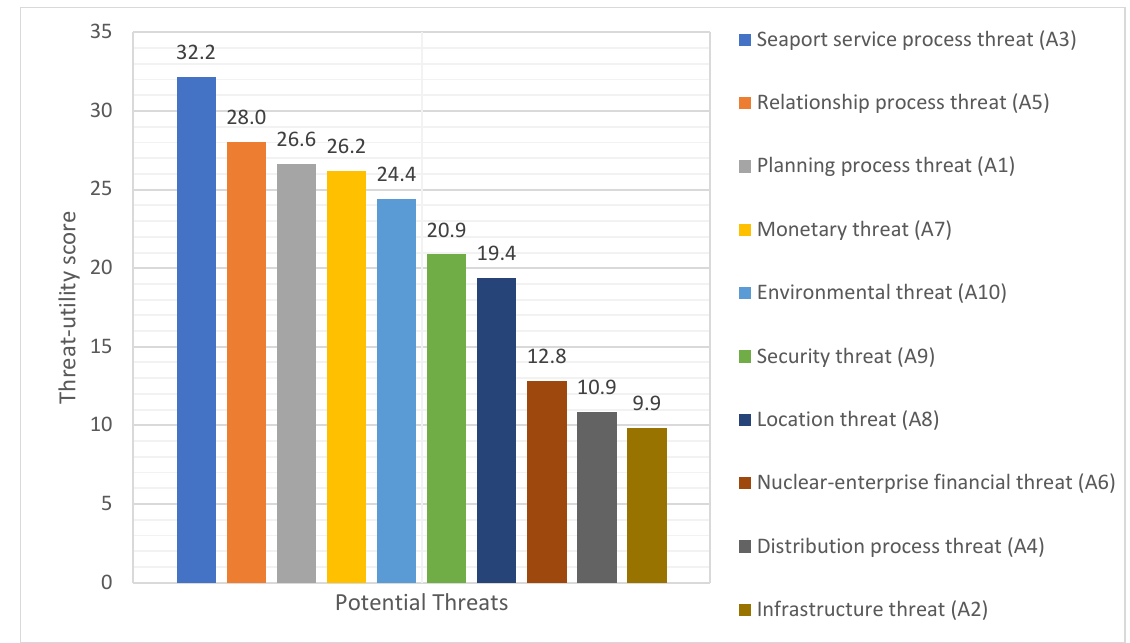
Figure 4. Potential threats of the PSCRD in Indonesia. Table 7. Estimated utility of PSCRD factors.